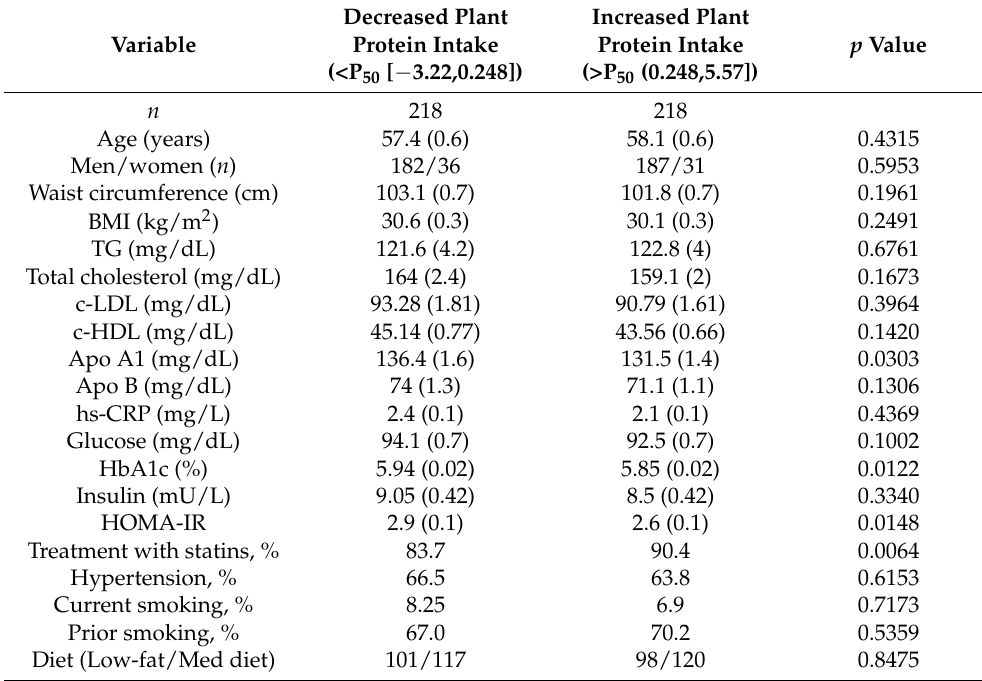
Table 1. Baseline characteristics of study participants according to the median of ∆ in plant protein (percentage of energy (% E)) consumption.